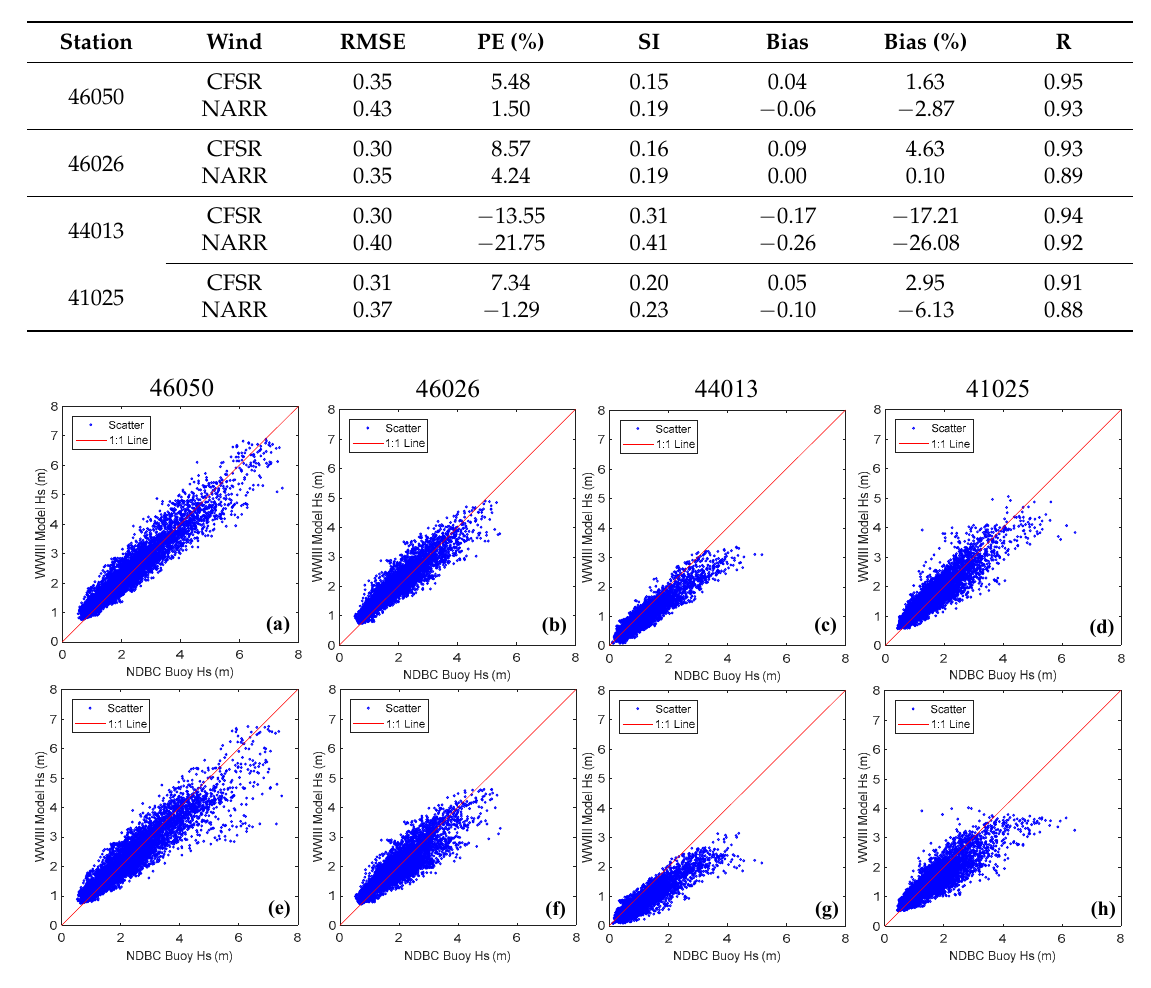
Table 5. Performance metrics for WWIII simulations with NARR wind.